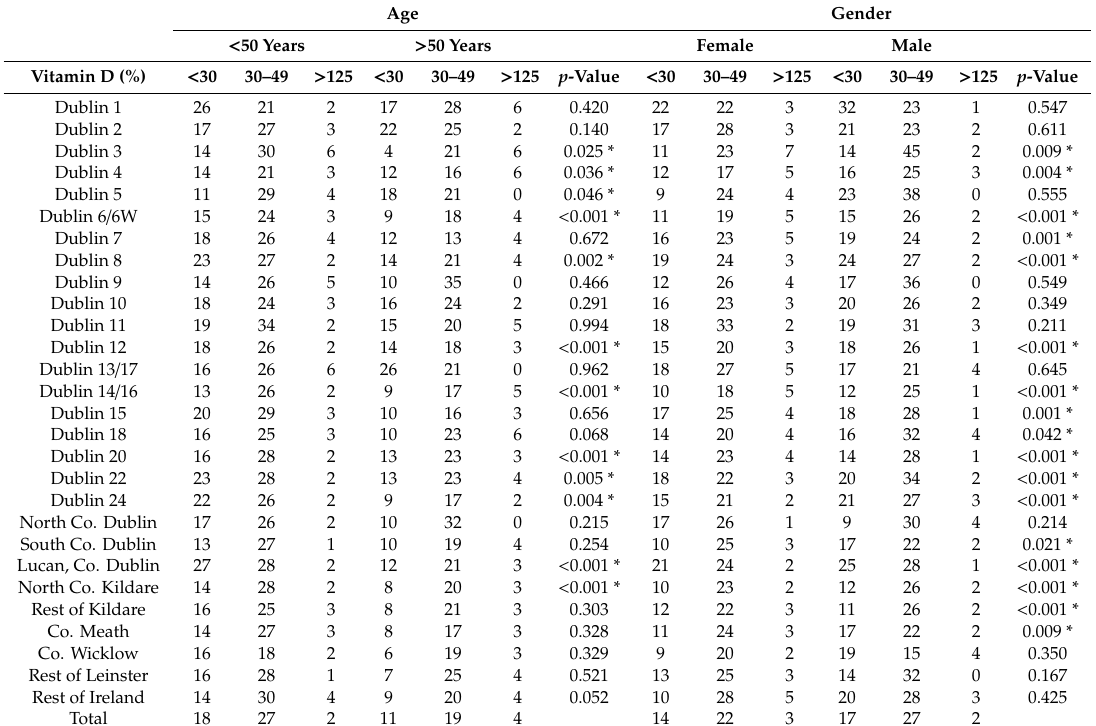
Table 5. 25(OH)D Status by location, age and